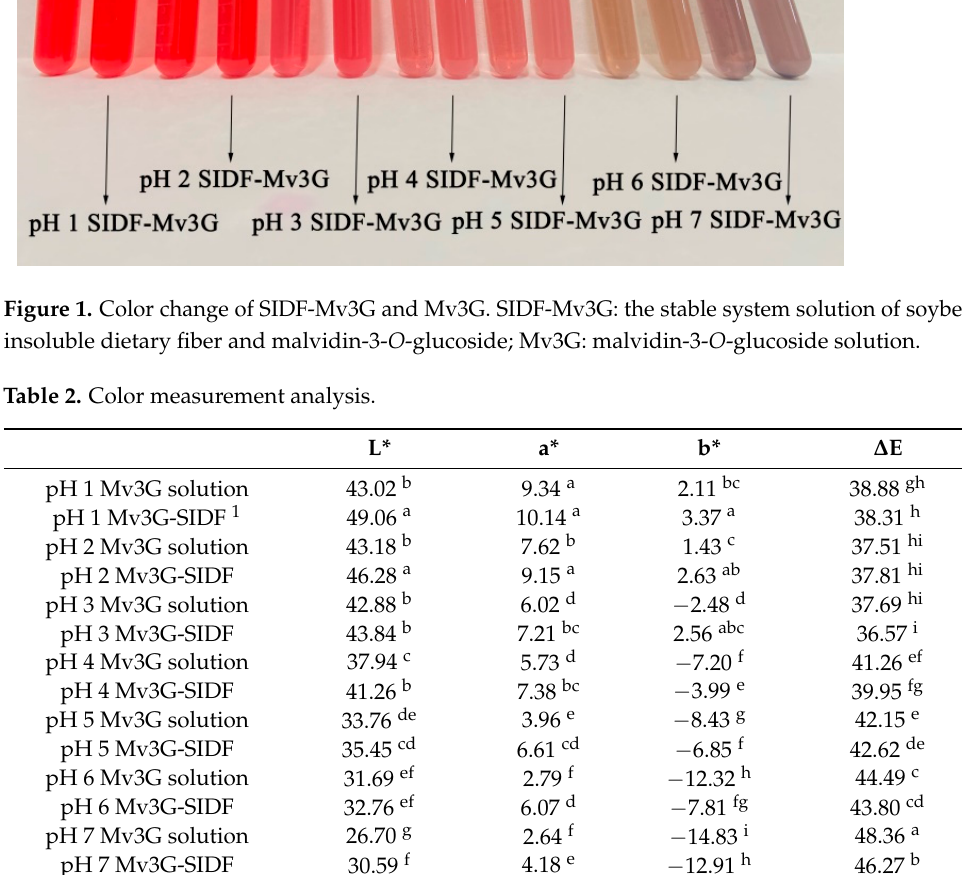
Table 2. Color measurement analysis.